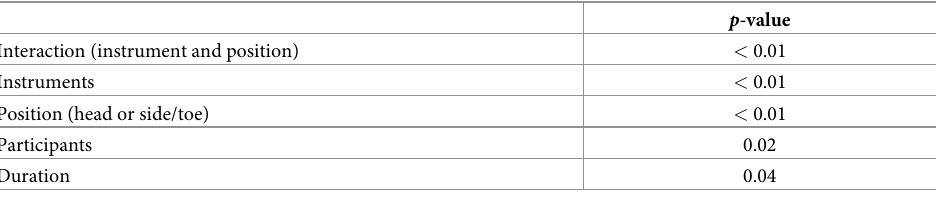
Pulse rates (Fig 4) Pulse rates after the task were 136.4 bpm, 132.5 bpm, 135.5 bpm and 127.9 bpm for the AD, AL, BL and TL conditions, respectively. However, the univariate analyses did not reveal any significant differences in pulse rates among the four carrying methods ( p = 0.36). Table 2. Multiple least squares regression